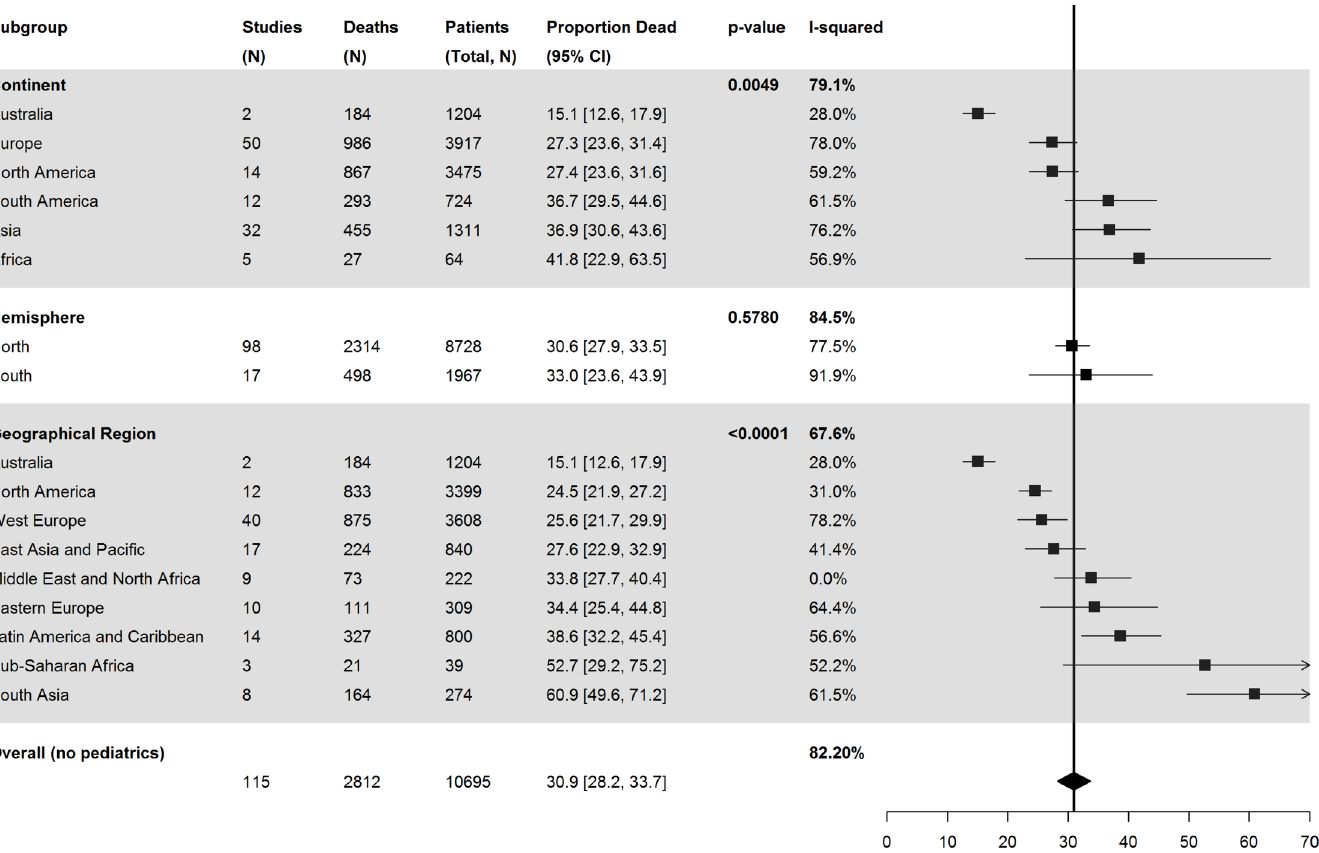
Fig 3. Differences in reported mortality based on different geographic variables for the included countries (hemisphere, continent and World Bank designated geographical region). The Black squares represent the point estimate and 95% confidence intervals (CIs) around the mortality for each subgroup. The black diamond is the summary or overall combined estimate of mortality associated with the 2009 Influenza A (H1N1) pandemic. The use of geographical regions is associated with the best discriminative power to report the differences in mortality in a global